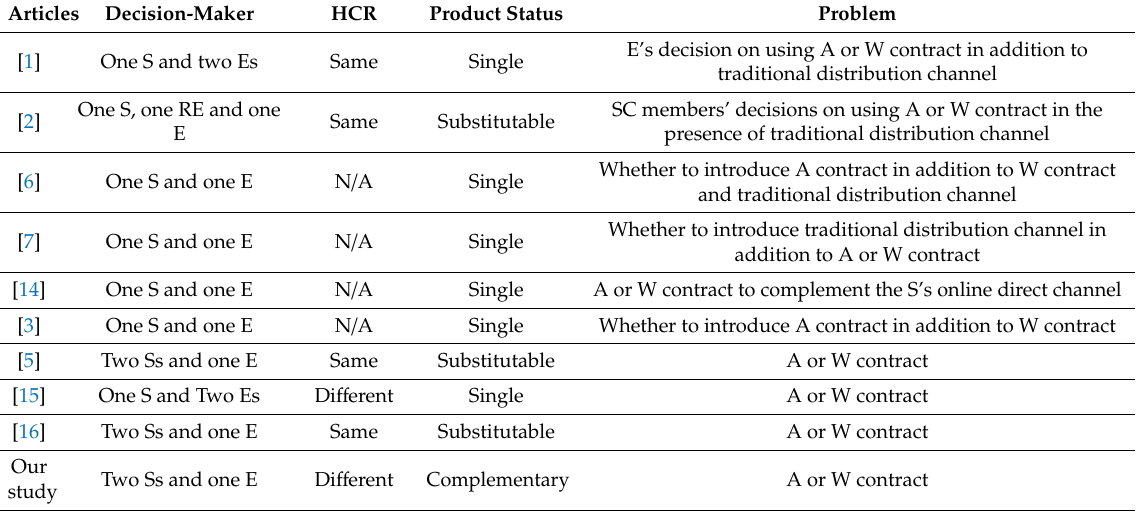
Table 1. Articles on